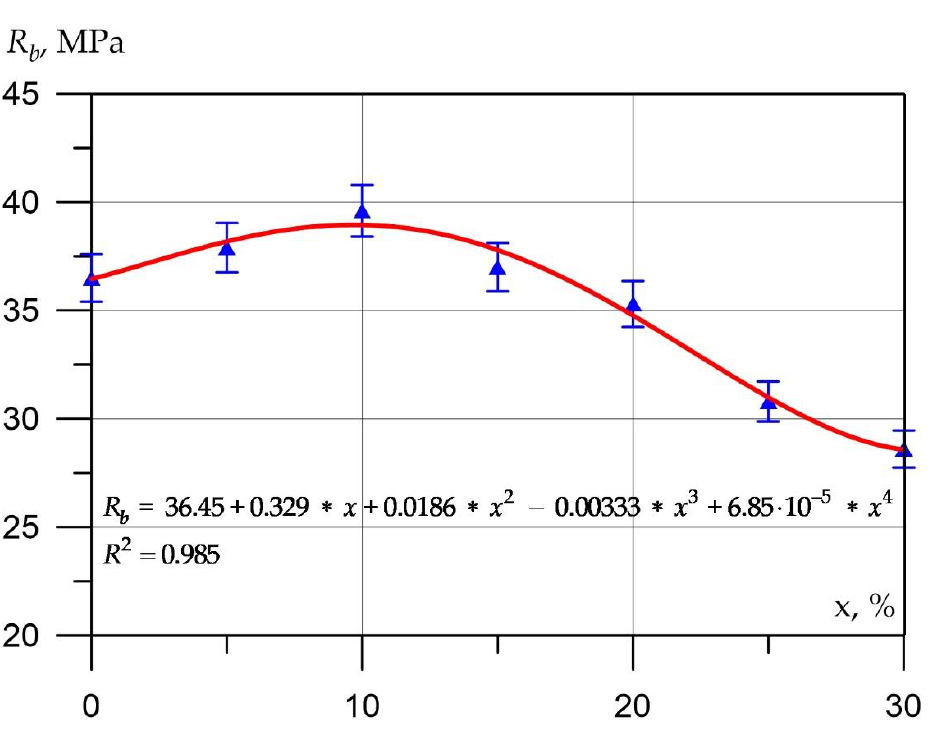
Figure 4. Dependence of the axial compressive strength of concrete on the amount of eggshell powder.